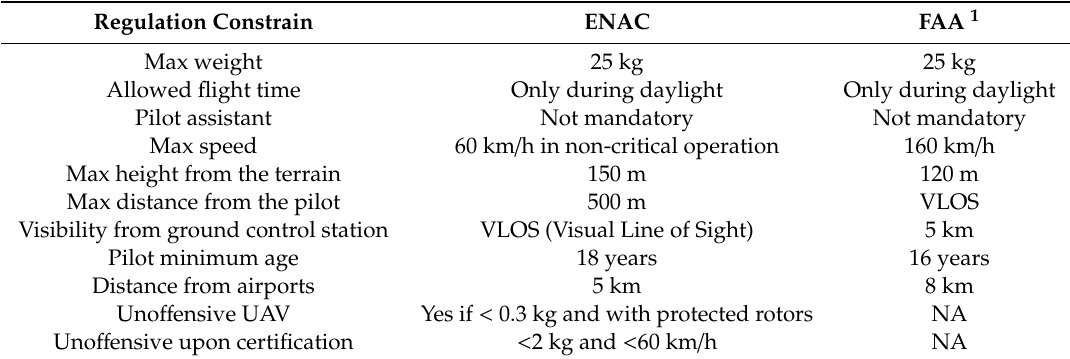
Table 6. Comparison between the regulatory constraints for small unmanned aircraft rule according to the European ENAC regulation and the American Federal Aviation Administration (FAA)